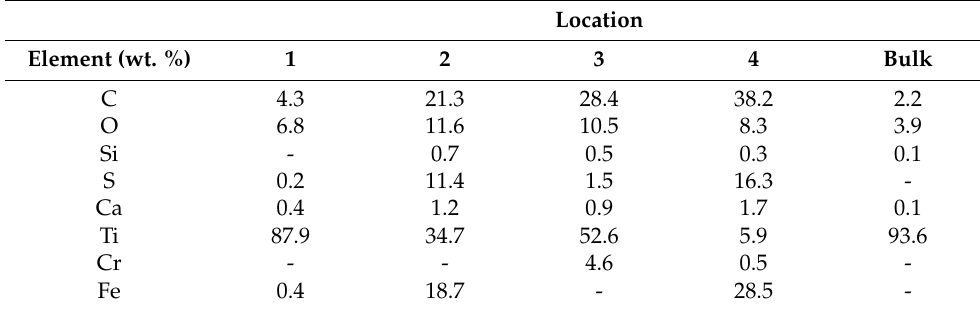
Figure 19. Ti gr. 2 after exposure at Chaunoy where there is visible detachment of Ti subsurface. The detached material is seen in location number 1. Furthermore, locations 2 and 4 contain Ti with high amounts of Fe and S. The colour map shows the relative composition of Fe, Ti, Ca, S and C in the material. Table 13. EDX elemental analysis of locations shown in Figure 19. For comparison, an analysis of the bulk material after exposure at Chaunoy is